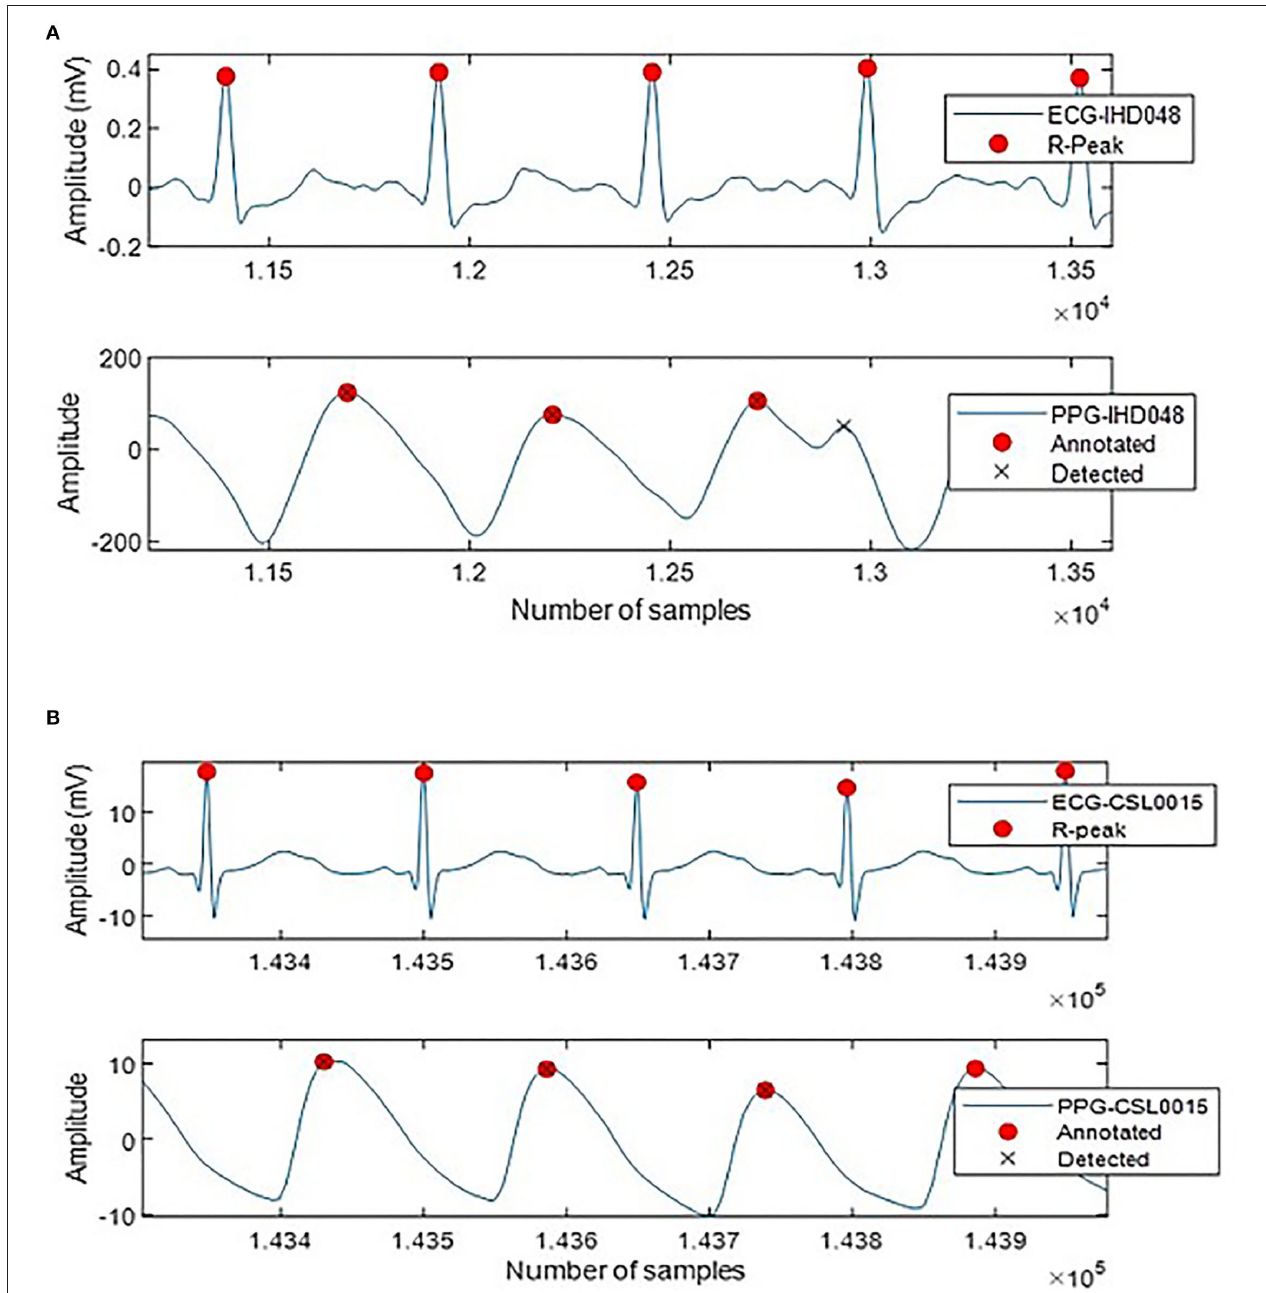
FIGURE 5 | Annotated and detected systolic peak of (A) IHD048 with one false peak, (B) CSL0015 with one undetected